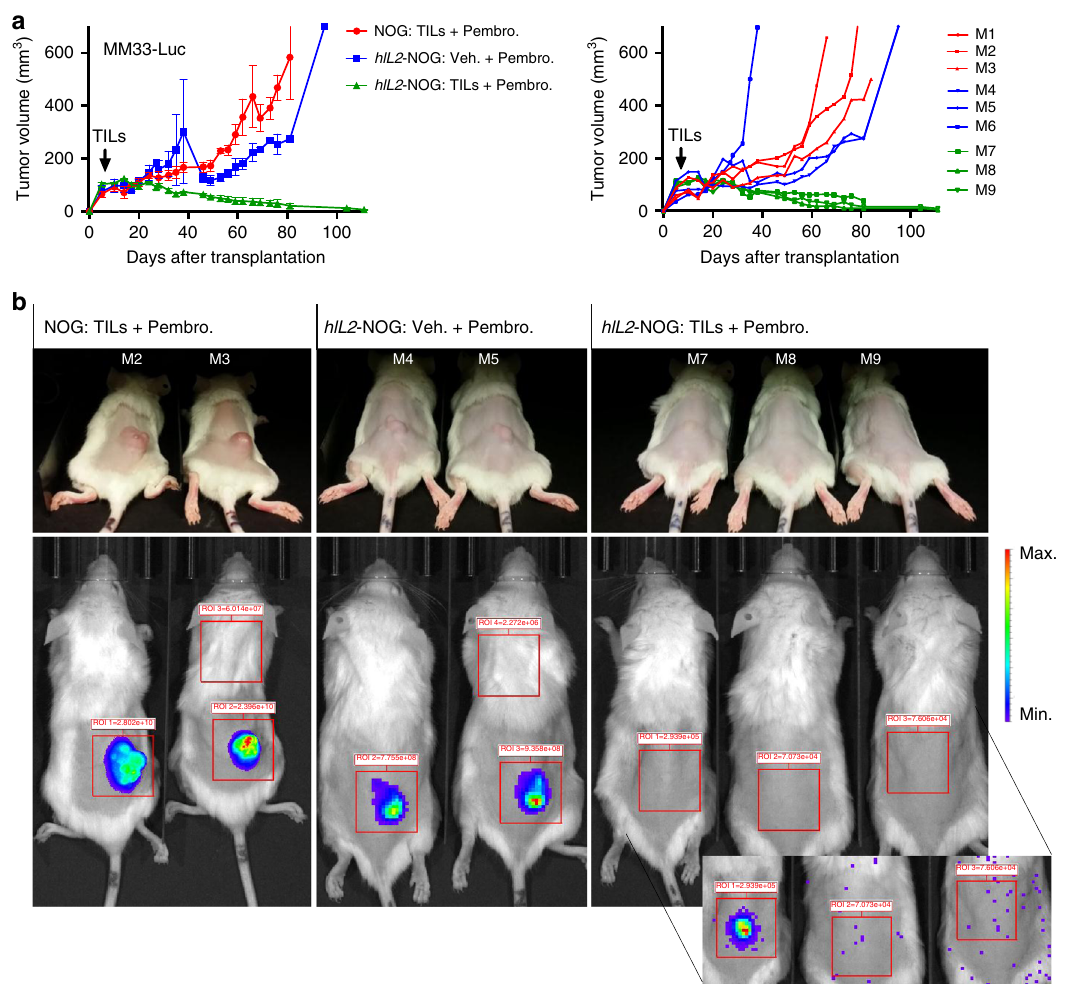
Fig. 3 Transgenic expression of human IL2 enables TIL-mediated tumor eradication in NOG mice. a Six hIL2 -NOG transgenic mice and three NOG mice were transplanted with luciferase labeled MM33 tumor cells. After tumor growth had been con fi rmed by IVIS imaging, all NOG mice, and three of the hIL2 - NOG mice, were injected with autologous REP TILs and tumor growth was measured with calipers. Shown to the right are individual mice. b IVIS imaging to investigate if mice are disease free. Inset , very prolonged exposure yielding mostly spark signals from static electricity. The experiment described here was performed once, follow-up experiments con fi rming the data are in Fig. 4 and Supplementary Fig.